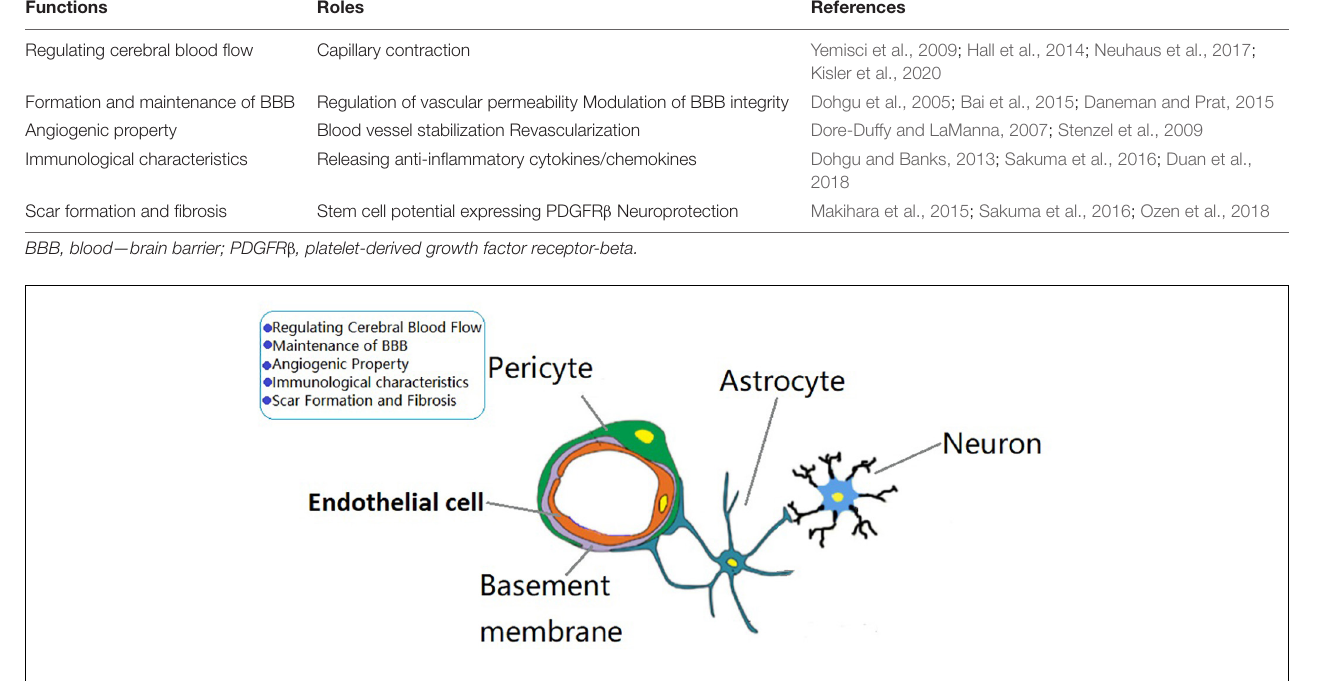
FIGURE 1 | The role of brain pericytes at the neurovascular unit (NVU). A simplified NVU is composed of vascular cells [pericytes, vascular smooth muscle cells, endothelial cells (ECs)], glial cells (astrocytes, microglia, oligodendrocytes), and neurons. Pericytes have the functions of regulating cerebral blood flow, maintenance of blood—brain barrier permeability, angiogenic characteristcs, immune responses, and scar formation and